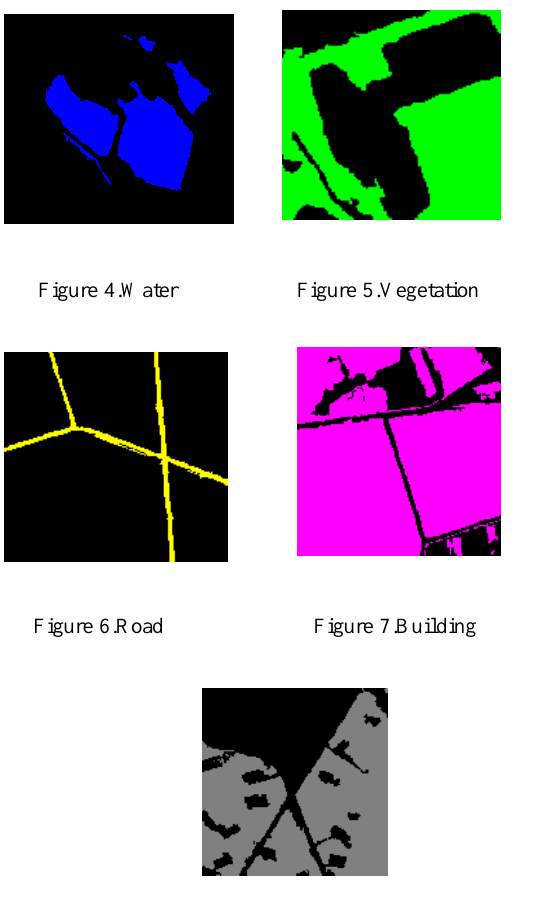
Figure 8.Bare Land